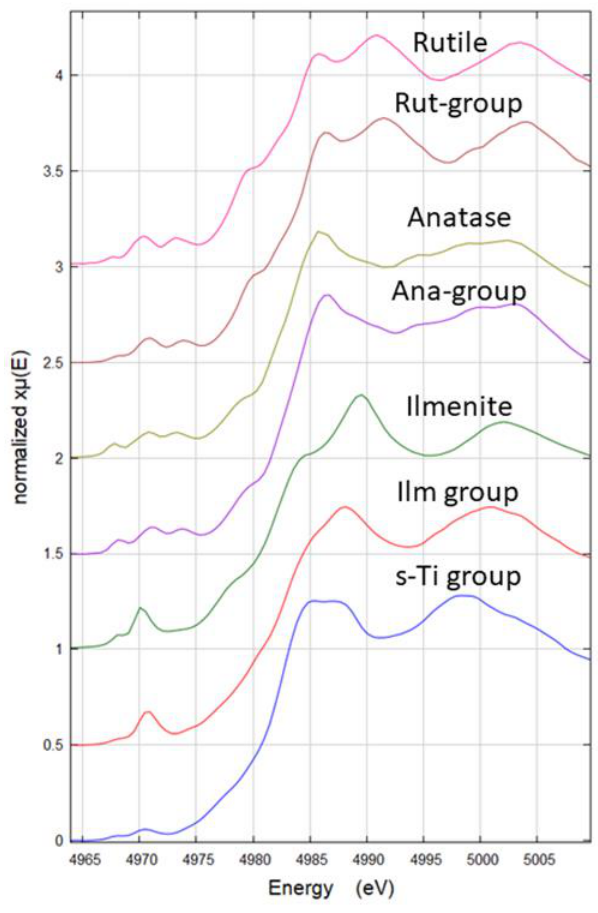
Figure 5. Experimental micro X-ray Absorption Near-Edge Structure (µXANES) spectra of each group from the PCA analysis (Rut-group, Ana-group, Ilm-group, and s-Ti group) and the corresponding µXANES spectra of references (rutile, anatase, ilmenite). s-Ti group was compared with the theoretical spectra of compounds shown in Figure S1 and Table S1. The XANES spectra named ‘group’ are the average of all instances in each group.